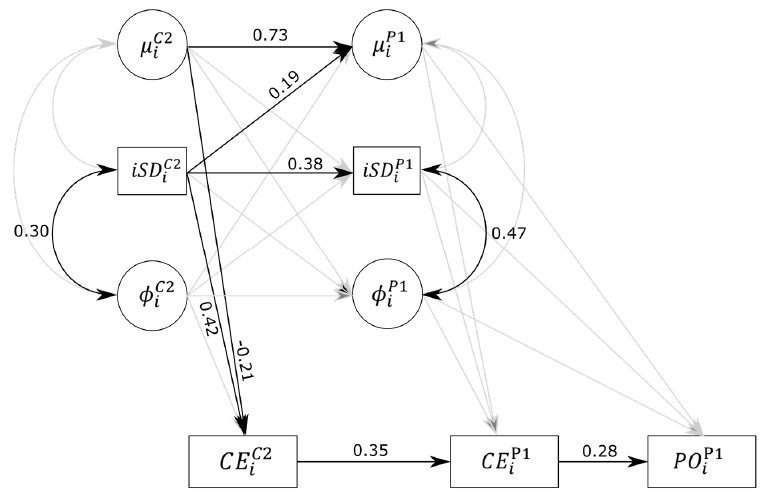
Figure 2. Path diagram for model M9 results. Variables represented in circles are parameters estimated within the dynamic structural equation modeling (DSEM) based on individual RTs, namely mean-level RT ( µ i ) and the autoregressive parameter of order 1 ( φ i ) in Classical Go/NoGo (CGNG)2 and Prospective Go/NoGo (PGNG)1. Variables represented in rectangles are the intraindividual amplitude of fluctuations ( iSD i ), the total number of commission errors in CGNG2 and PGNG1 ( CE C 2 i and CE P 1 ), and the total number of prospective omissions in PGNG1 ( PO P 1 ). Parameters µ i , iSD i, and i i φ i are regressed on one another across blocks and allowed to covariate within blocks. Finally, error variables are regressed on µ i , iSDi , and φ i in their respective blocks. Single-headed arrows represent regression weights, double-headed arrows indicate covariances. Significant parameters and their corresponding standardized estimates are reported in black. Nonsignificant parameters are depicted in gray. Variances for each variable are not depicted but were nevertheless estimated and were all significant. R 2 = 0.58, R 2 = 0.18, R 2 = 0.16, R 2 = 0.25, R 2 = 0.24, R 2 = iSD P 1 CE P 1 PO P 1 CE C 2 µ P 1 φ P 1